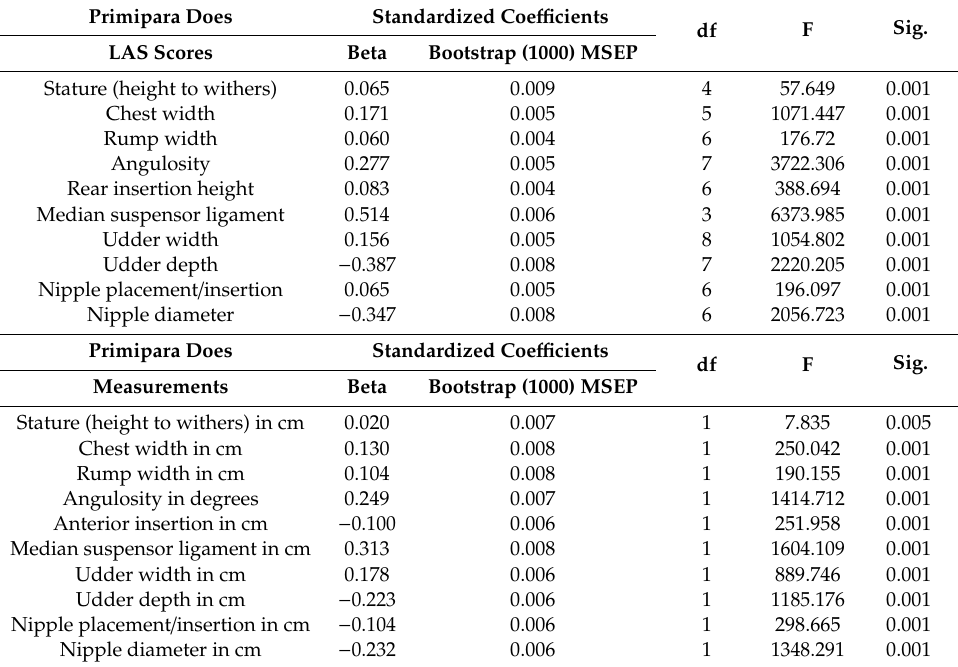
Table 4. β -standardized coe ffi cients to replace the Z score in each of the respective equations in Supplementary Table S5 and a 0.632 bootstrap mean squared error of prediction (MSEP) for the comparison of model validity between the two linear regression models using linear appraisal traits as opposed to Murciano-Granadina zoometric traditional assessment in does.